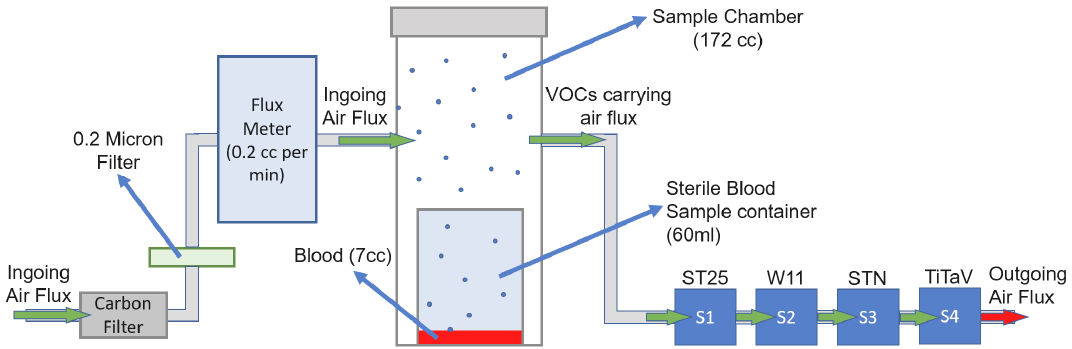
Figure 8. Block scheme of SCENT B1 pneumatic system.